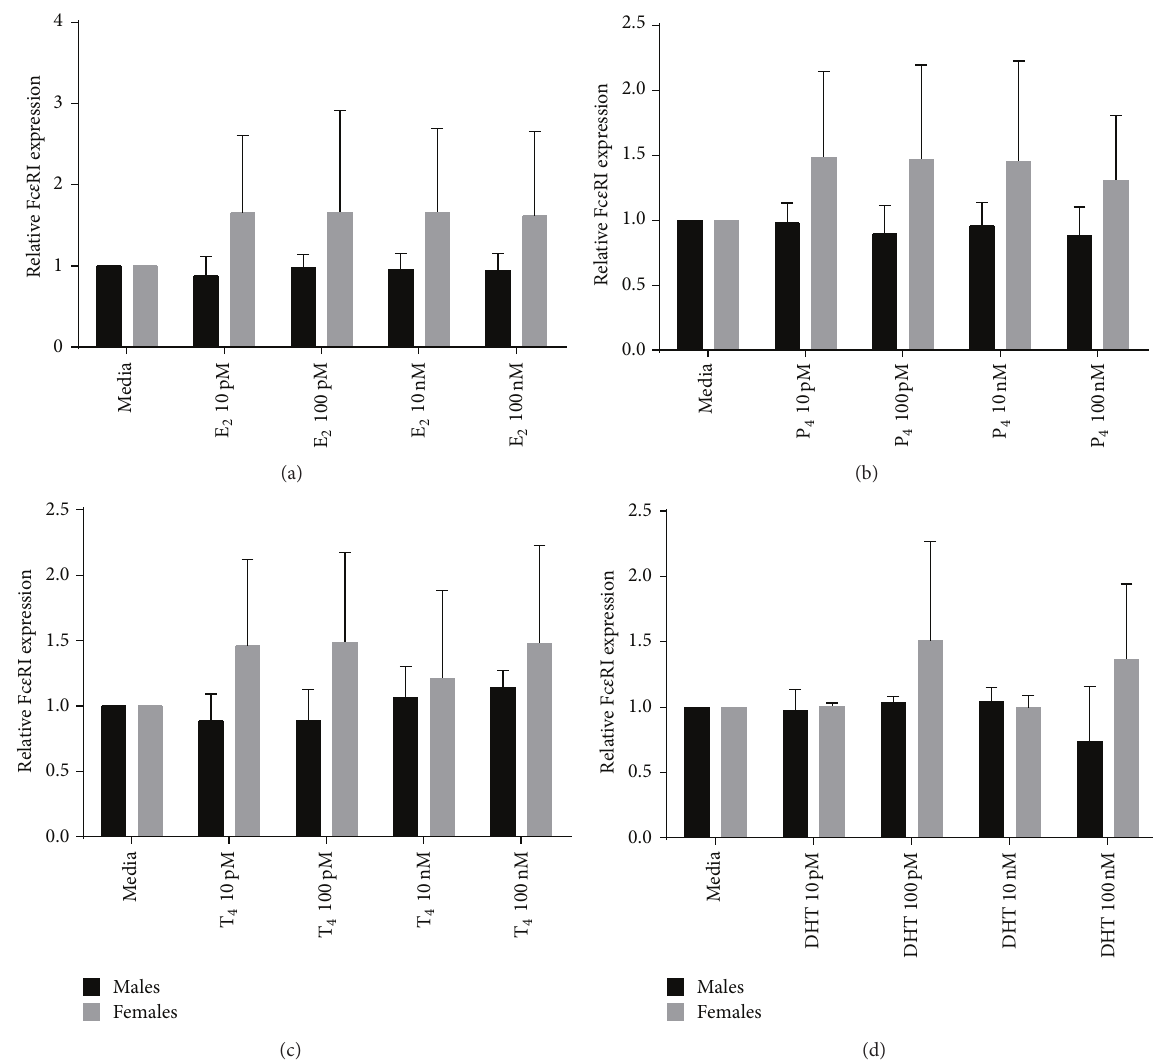
Figure 4: Fc 𝜀 RI expression on PMCs in response to E 2 , P 4 , T 4 , and DHT treatment. Fc 𝜀 RI relative expression in response to different concentrations of (a) E 2 , (b) P 4 , (c) T 4 , and (d) DHT. Relative expression was calculated as MFI (hormone-stimulated)/MFI (unstimulated control). 𝑁 = 5 for males and 𝑁 = 3 for